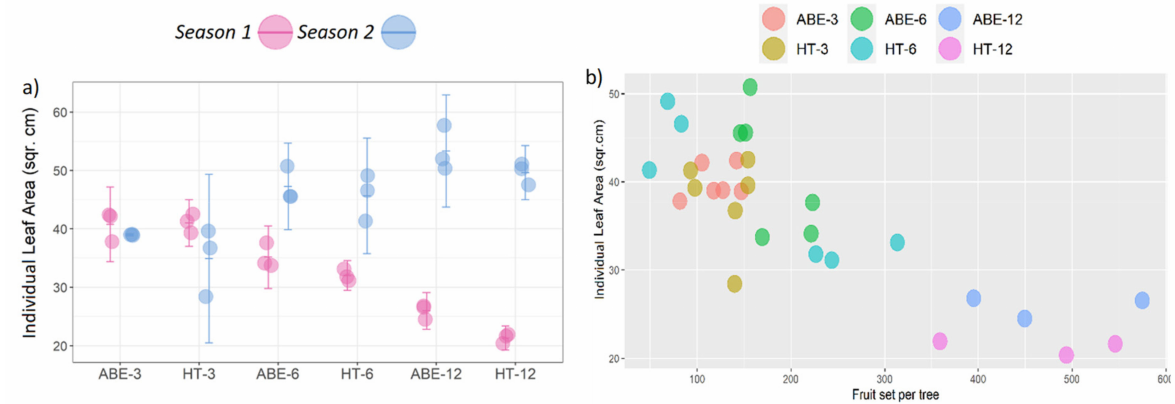
Figure 9. ( a ) Effect of thinning regime and crop load on individual leaf area (error bars represent 95% confidence interval) and ( b ) two years of compiled data showing a negative correlation (r = − 0.821) between fruit set/tree and individual leaf area. ABE = artificial bud extinction; HT = hand thinned.